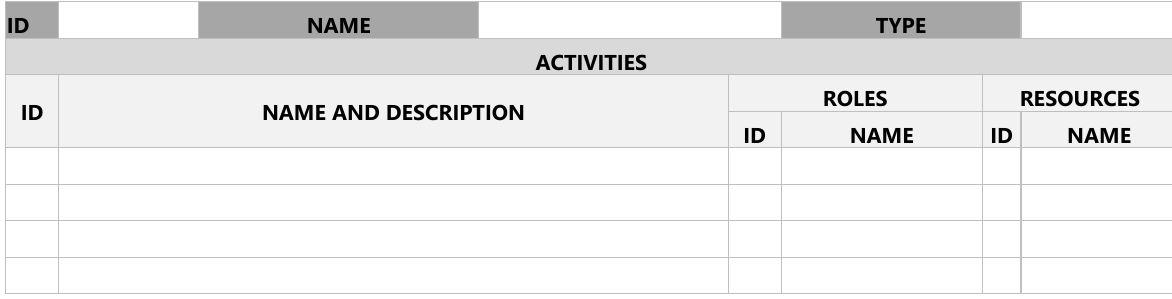
Figure 12. MBM Graphical Notation: Channel